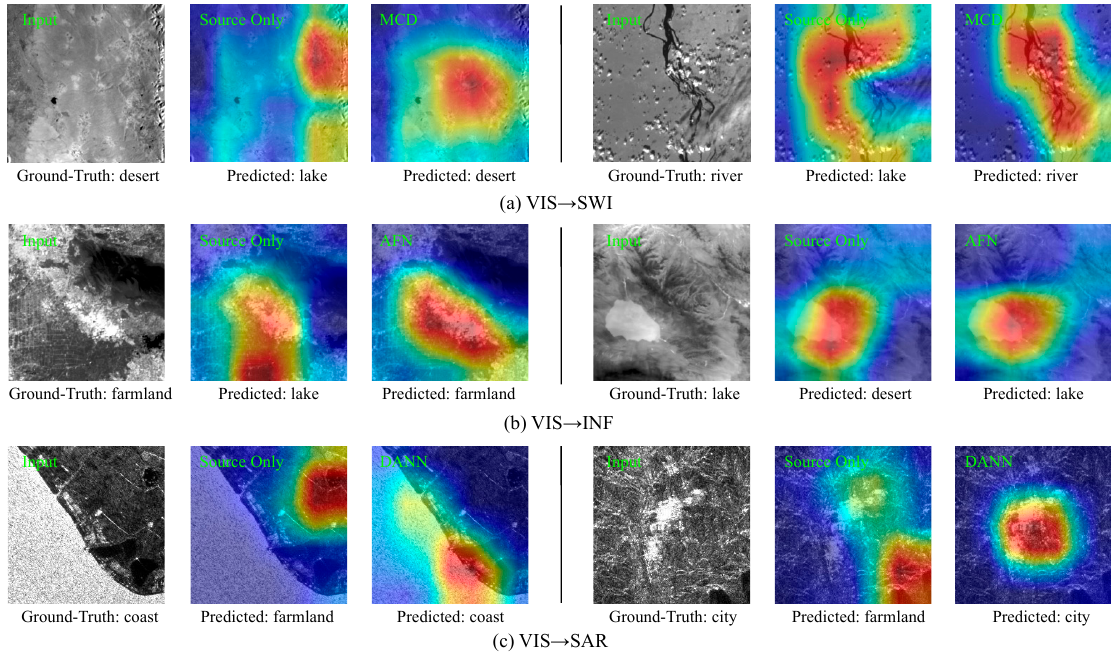
Figure 6. Grad-CAM visualizations of the predicted categories with source only and DA, where ( a ) VIS → SWI task, ( b ) VIS → INF task and ( c ) VIS → SAR task.